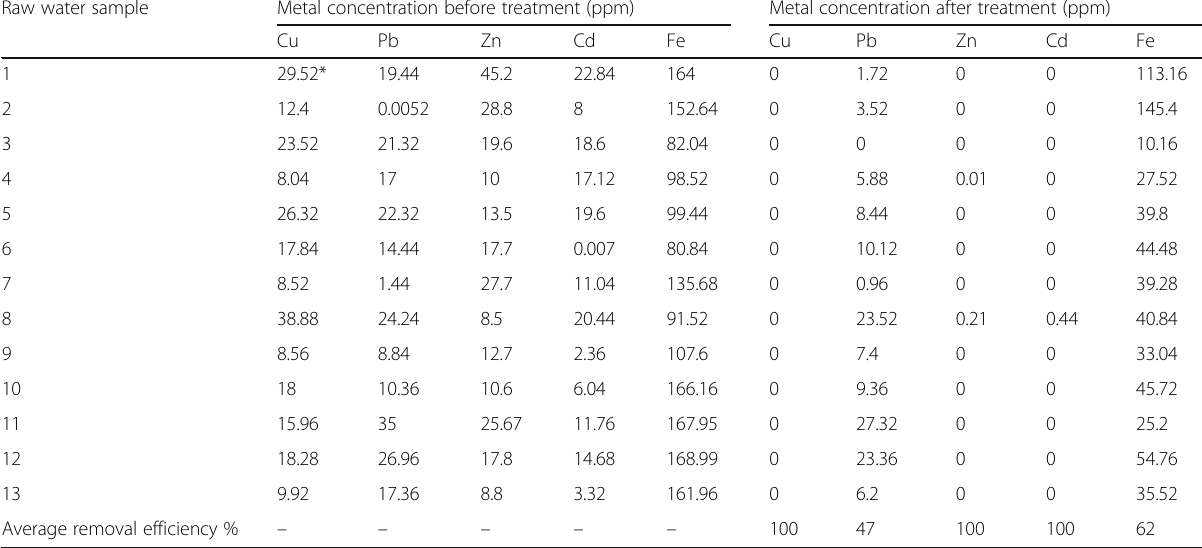
before and after the bio-treatment, respectively Raw water sample Metal concentration before treatment